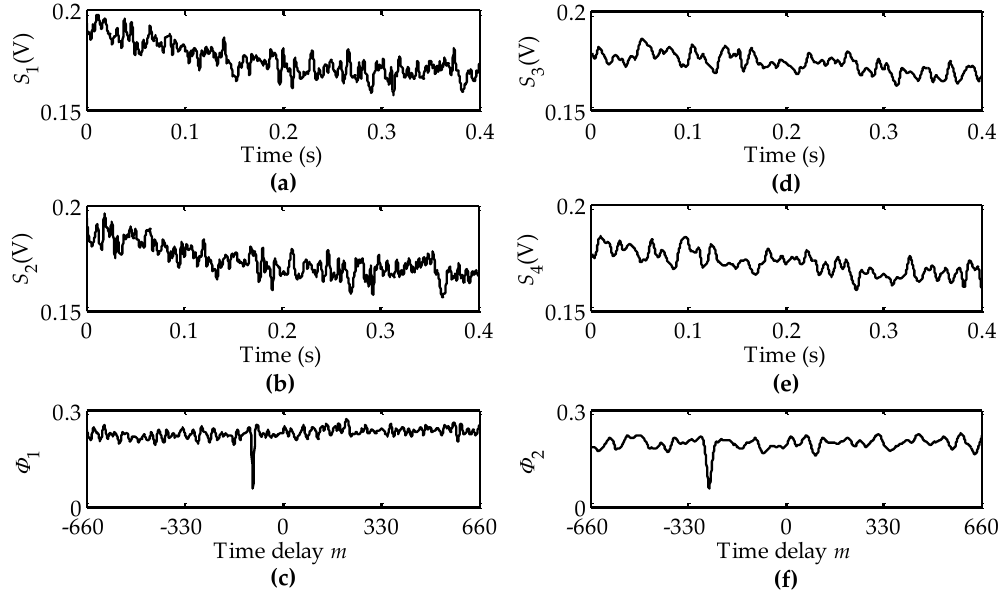
Figure 8. DSCs in the cases of the counter-clockwise rotation and the rotational center locating below both the LVS1 and the LVS2: ( a , b , d , e ) are output signals of the QPD; ( c ) time delay between signals S 1 and S 2 ; ( f ) time delay between signals S 3 and S 4 .